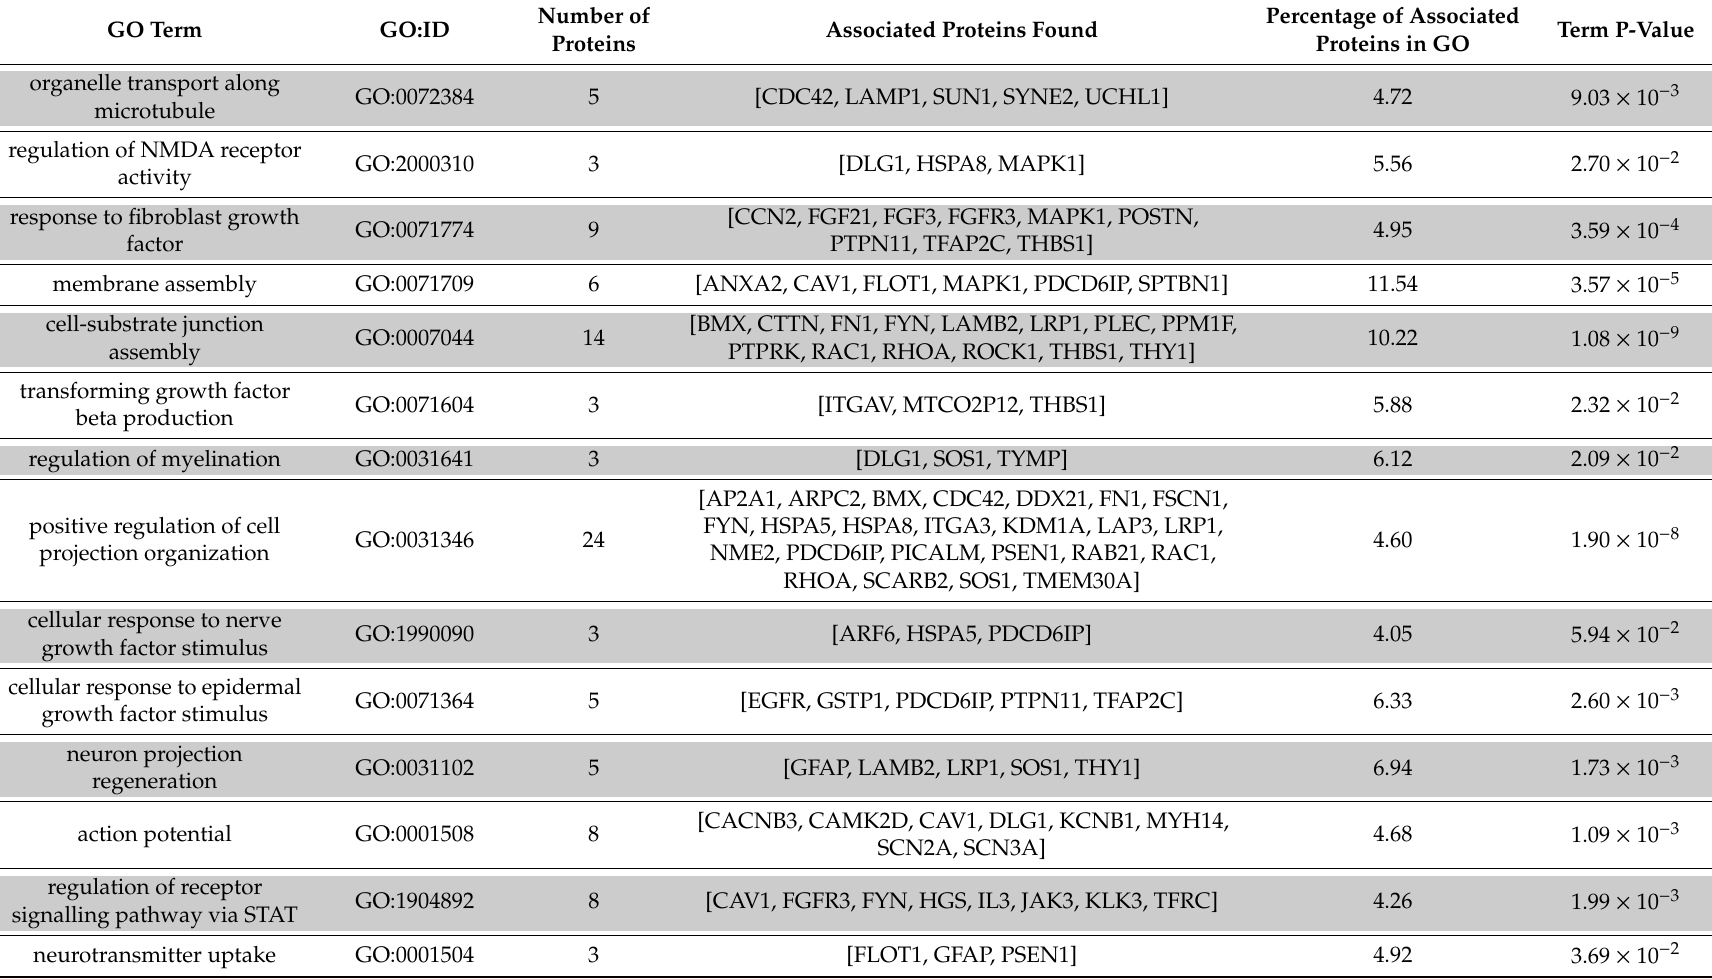
Table 2. The gene ontology of proteins associated in the neural-related ClueGO interaction and signalling network